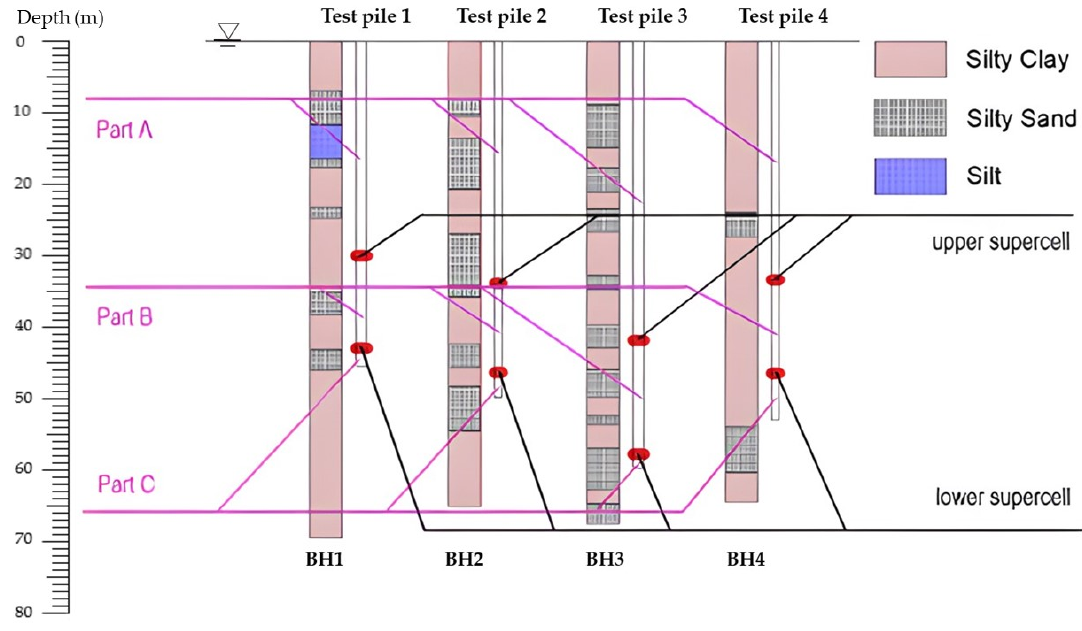
Figure 3. Subsurface conditions along test piles.